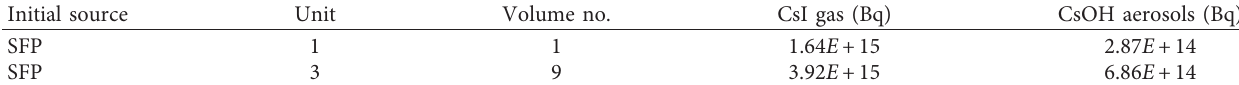
Table 4: Cesium source term in the SFPs used for calculation in Modified ART Mod 2.